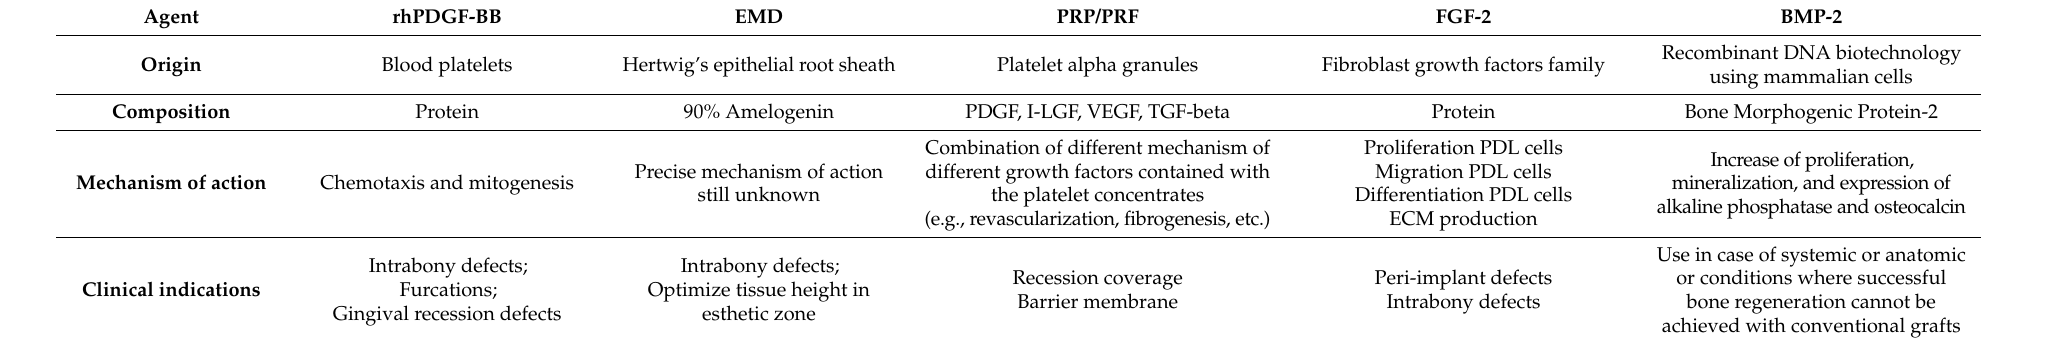
Table 3. Summary of the most relevant growth factors and their origin, composition, mechanism of action, and indications. Adapted from Ref. [82]. Copyright © 2015 Fernando Suarez-Lopez del Amo et